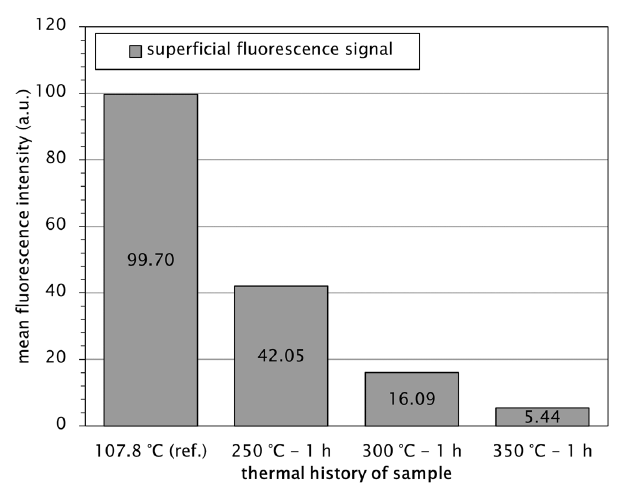
Figure 7. Thermal degradation behaviour of fluoresceine in coating C3-3 (suspension S3, gas flow